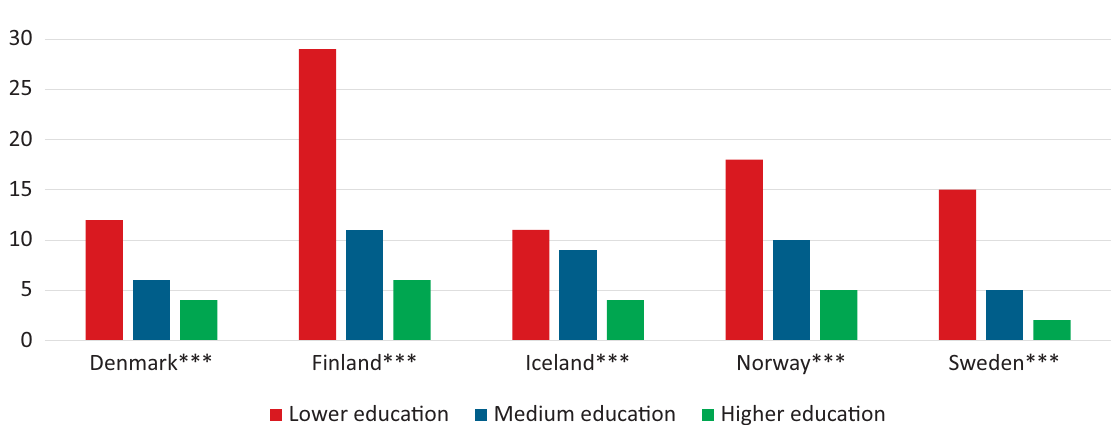
Figure 4. Percentage among different education groups agreeing that “a man’s job is to earn money; a woman’s job is to look after the home and family.” Notes: *p < 0.05, **p < 0.01, ***p < 0.001; Denmark: n = 3,261, gamma = − 0.37; Finland: n = 1,169, gamma = − 0.49; Iceland: n = 2,016, gamma = − 0.36; Norway: n = 1,102, gamma = − 0.42; Sweden: n = 1,174, gamma = −